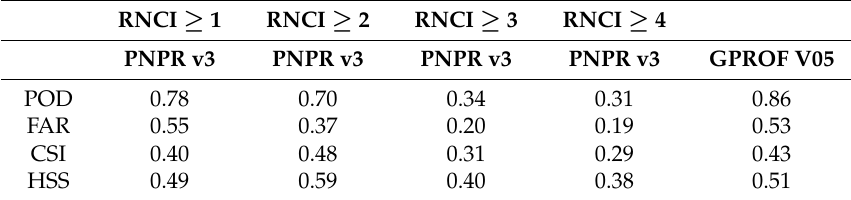
Table 9. Dichotomous statistical scores (POD, FAR, CSI and HSS) for PNPR v3 (for different RNCI thresholds) and GPROF with respect to ground-based radar estimates for the Livorno flash-flood case (GMI overpass at 01:17 UTC on 10 September 2017).